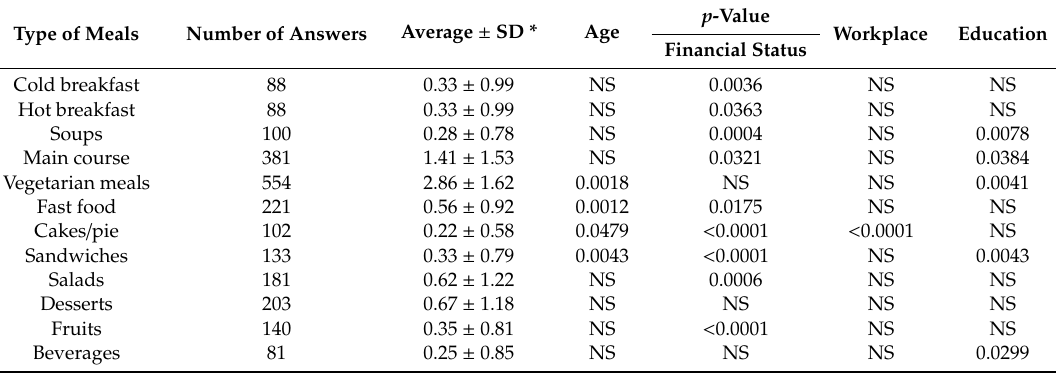
Table 2. Type of meals and frequency of eating at sta ff canteen by respondents ( n = 600). Type of Meals